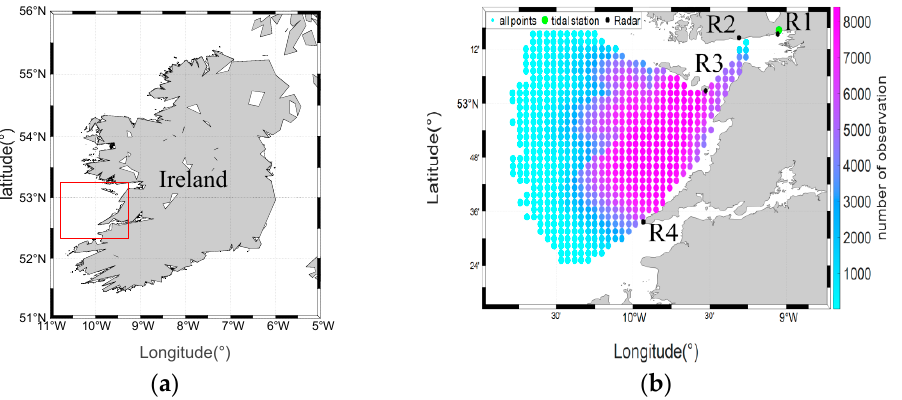
Figure 1. Study area and HFR coverage. ( a ) location of study area; ( b ) HFR coverage area and radar sites (R1–R4 indicate the four HFR sites in the study area, respectively).